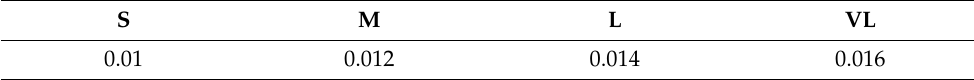
Table 3. X 2 Reference values in BRB1.